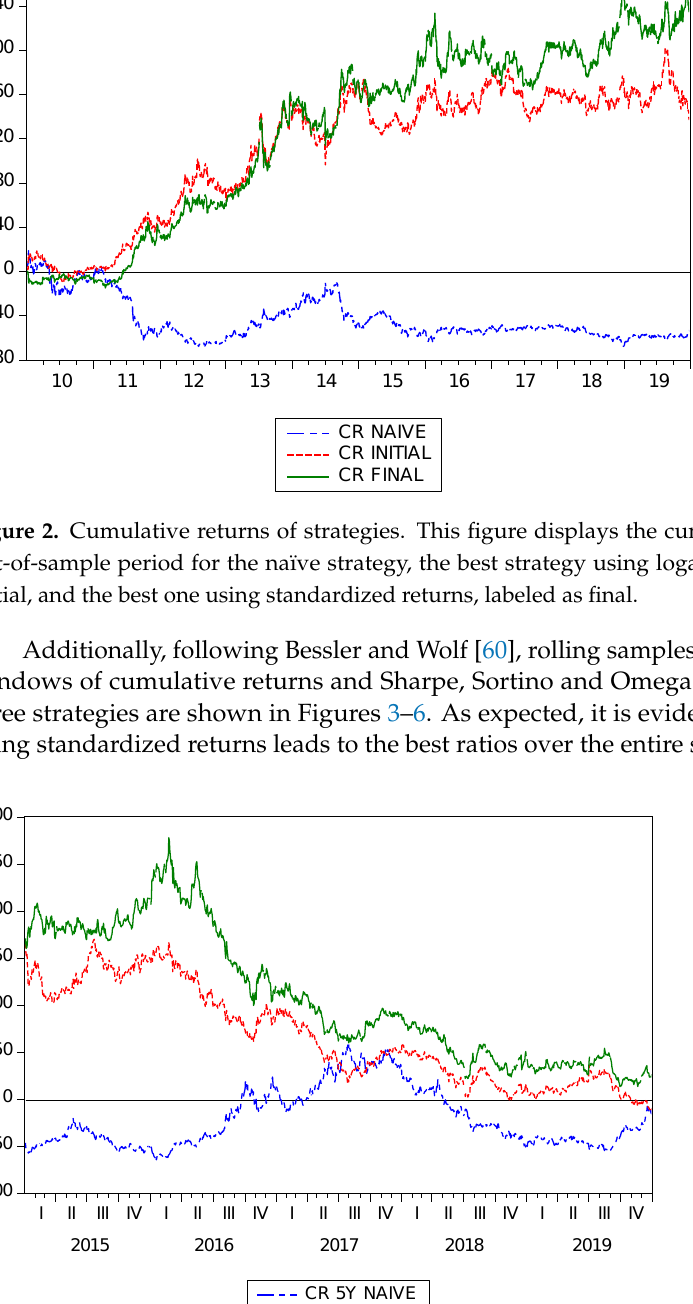
ratios are reported in annualized terms.